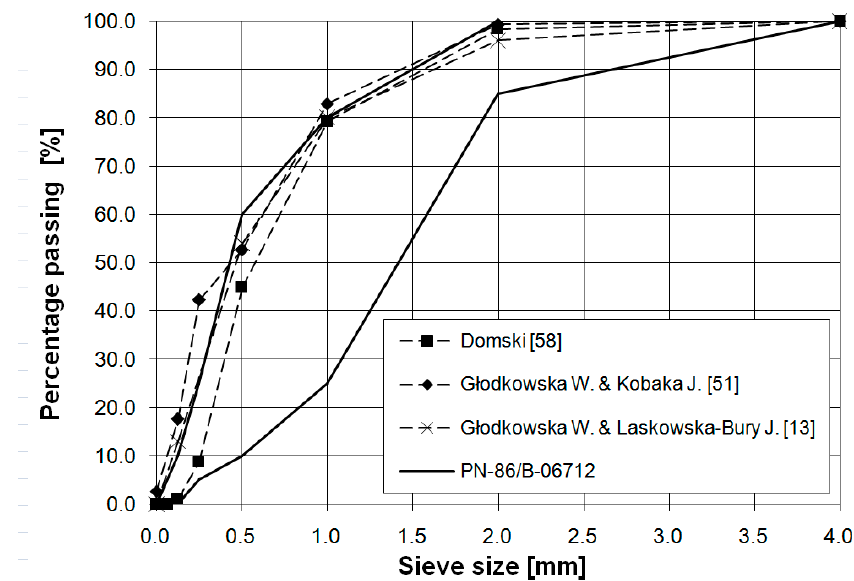
Figure 2. Grading curve of used aggregate and grading curves of other Pomeranianaggregates used in different research programs [13,51,58]. Reproduced with permission from ref. [52]; published by Middle Pomeranian Scientific Society of the Environment Protection, 2017.